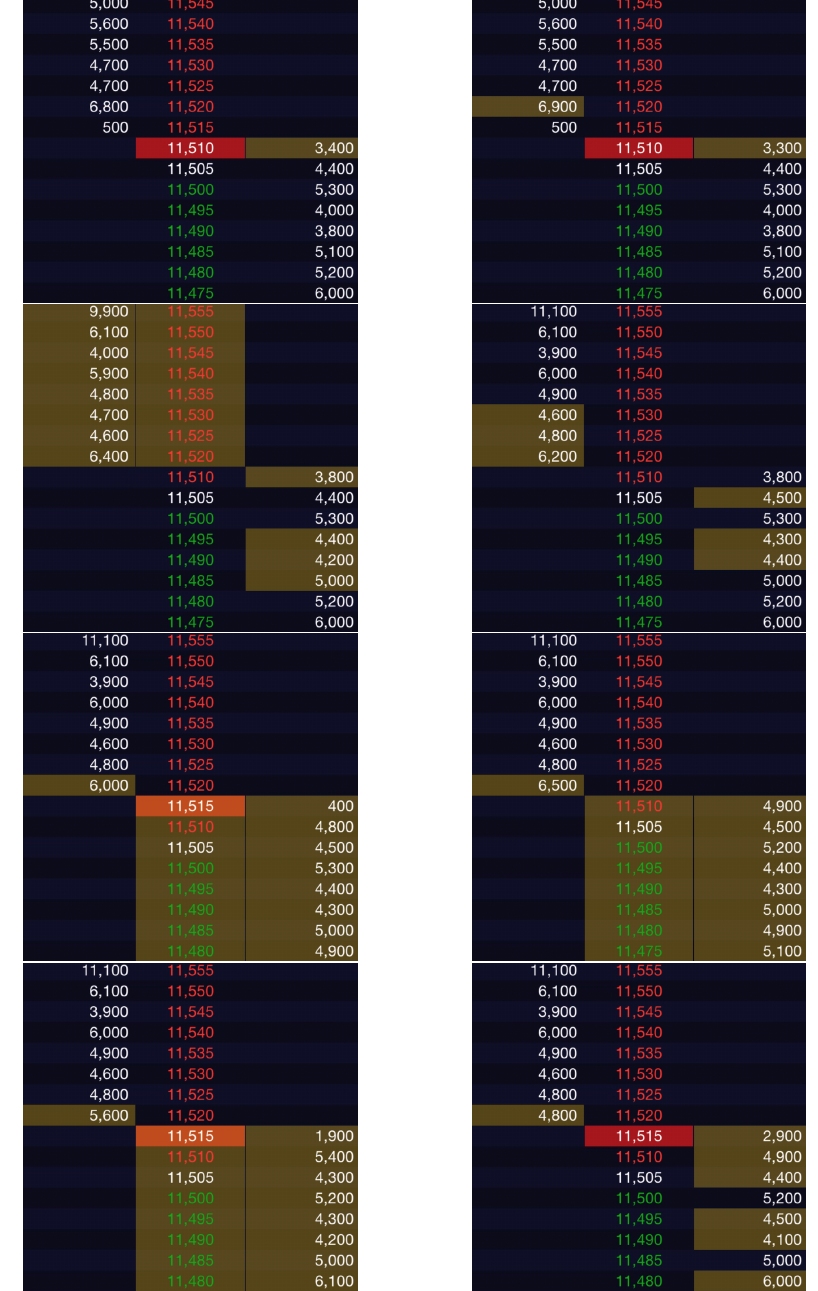
Figure 1. Trading process of Sony(6758) at 9:22 on 28 June 2022. The time is updated from left to right and from top to bottom. First, a trade is executed at JPY 11,500 in the upper left figure. Next, in the upper right diagram, a sell order for 100 shares is generated at JPY 11,510, and the trade is executed, and at the same time, a sell order for 100 shares is generated at JPY 11,520 . The transaction proceeds in the same